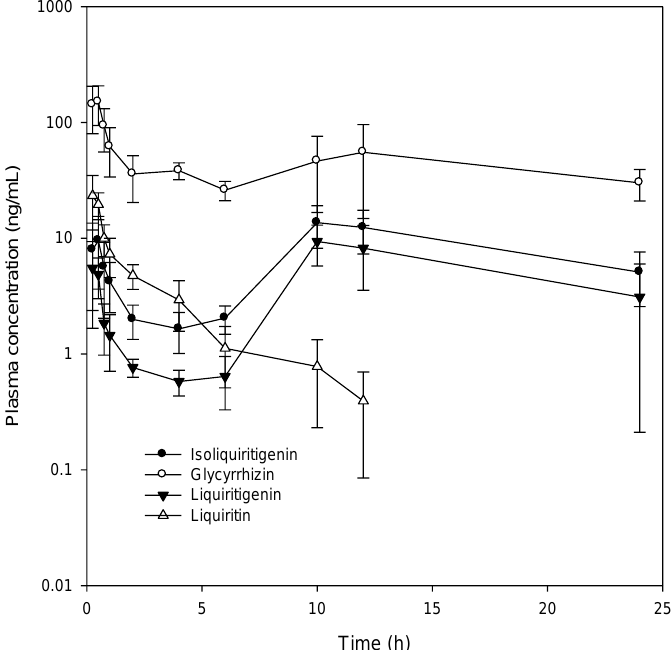
Table 7. Pharmacokinetic parameters of glycyrrhizin, isoliquiritigenin, liquiritin, liquiritigenin after oral administration of GRE (1 g/kg) to rats.